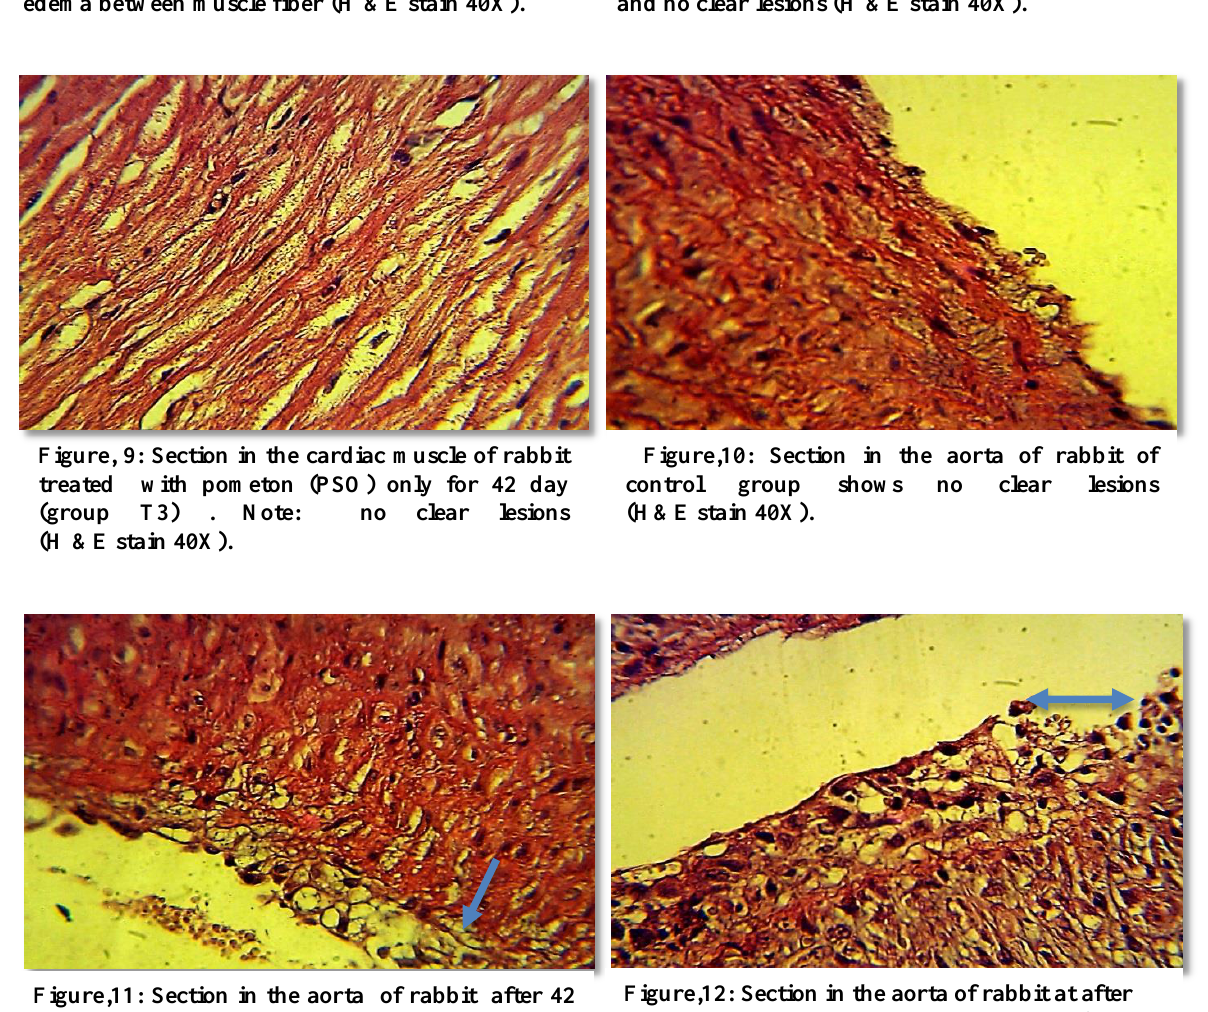
Figure,8: Section in the cardiac muscle of rabbit after 42 day of treatment with methionine over load and pometon (group T2 ) .Note: congestion and no clear lesions (H &E stain 40X).